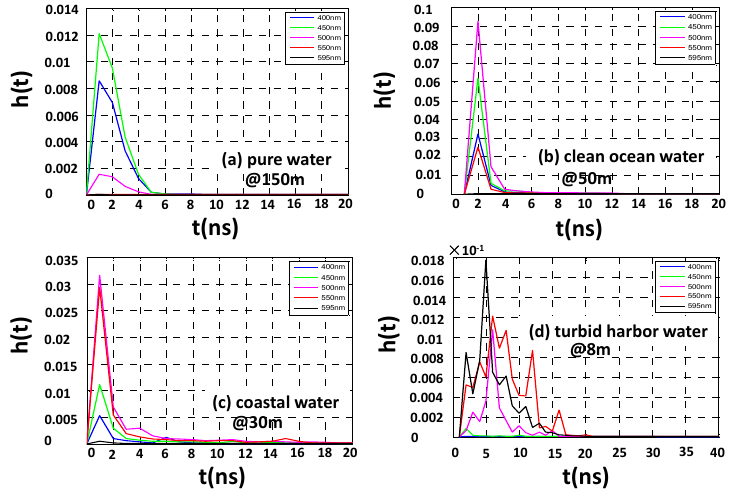
Figure 4. Channel response of different wavelengths in four types of water. The launched wave- lengths were set to 400 nm, 450 nm, 500 nm, 550 nm, and 595 nm, respectively. ( a ) pure water ( 𝑐 = 0.056 m − 1 ), ( b ) clean ocean water ( 𝑐 = 0.151 m − 1 ); ( c ) coastal water ( 𝑐 = 0.398 m − 1 ); ( d ) turbid harbor water ( 𝑐 = 2.17 m − 1 ).